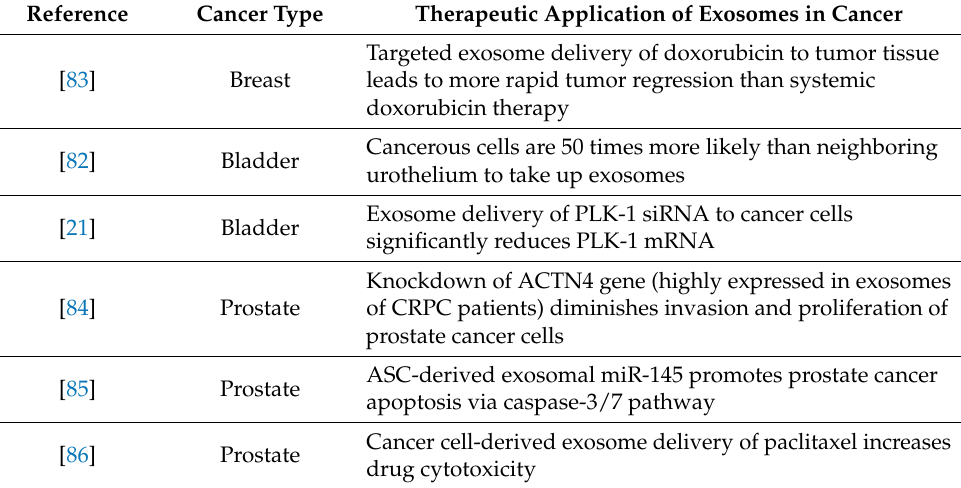
Table 3. Summary of evidence on potential value of exosomes in cancer therapeutics including prostate